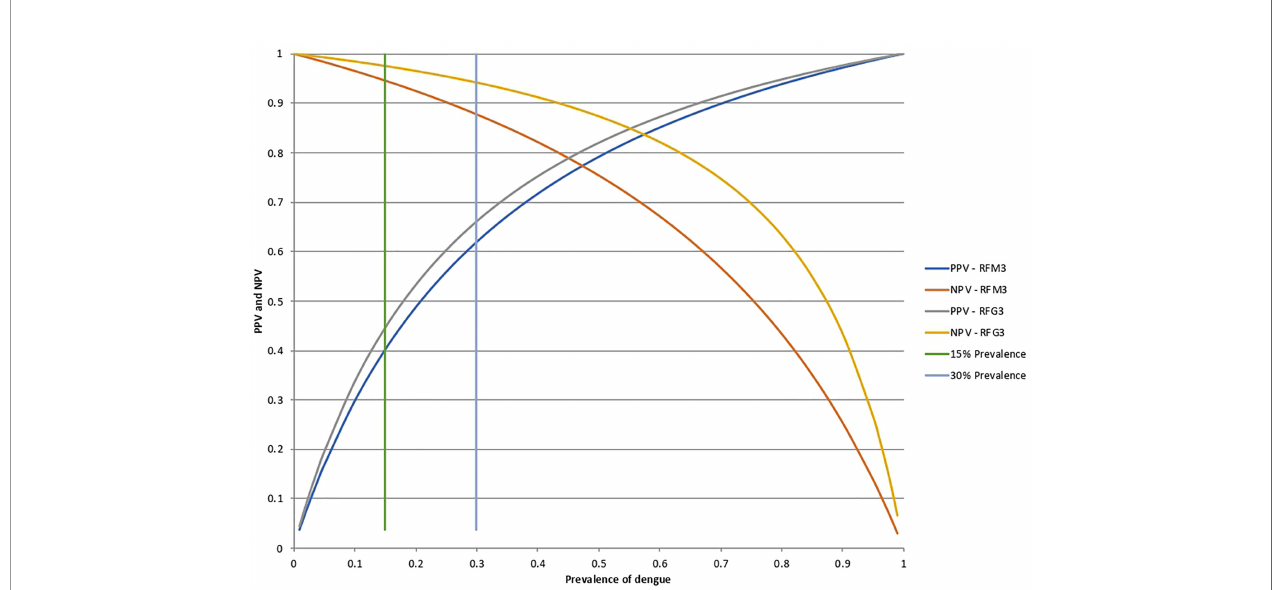
FIGURE 6 | Positive predictive values (PPV) and negative predictive values (NPV) for the RFM3 and RFG3 models. According to the Random Forest analysis for the combination of multiple peptides, the calculated speci fi city and sensitivity values were fi xed at 80% and 74% for the RFM3 model, and 80% and 88% for the RFG3 model, respectively. The RFM3 model included the following peptides: PM-22, PM-2, PM30, PM-34, PM-23, and PM-12. The RFG3 model included the FPG-1, PG- 40, PG15A, PG-33, PG-1, and PG-9 peptides. PPV and NPV calculated at a pre-set DENV prevalence of 15% and 30%, which corresponds prevalence which corresponds to the intersection of the horizontal bars with the